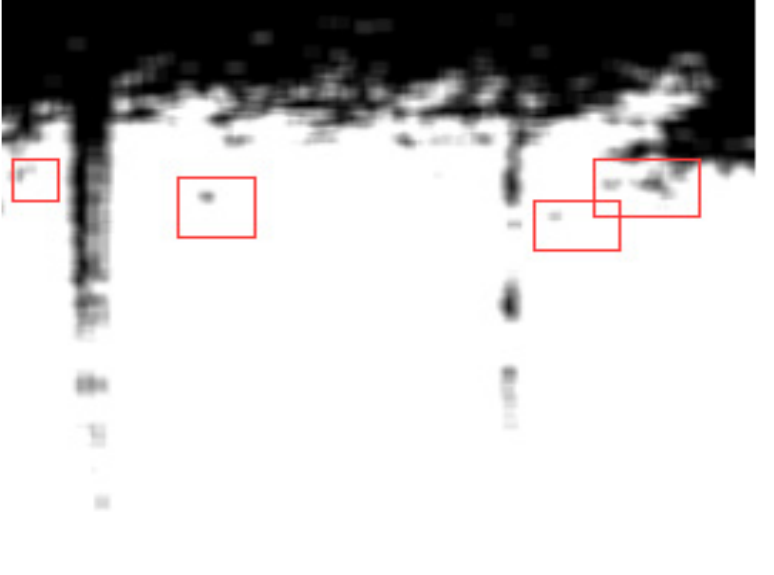
Figure 5. The image before pooling.